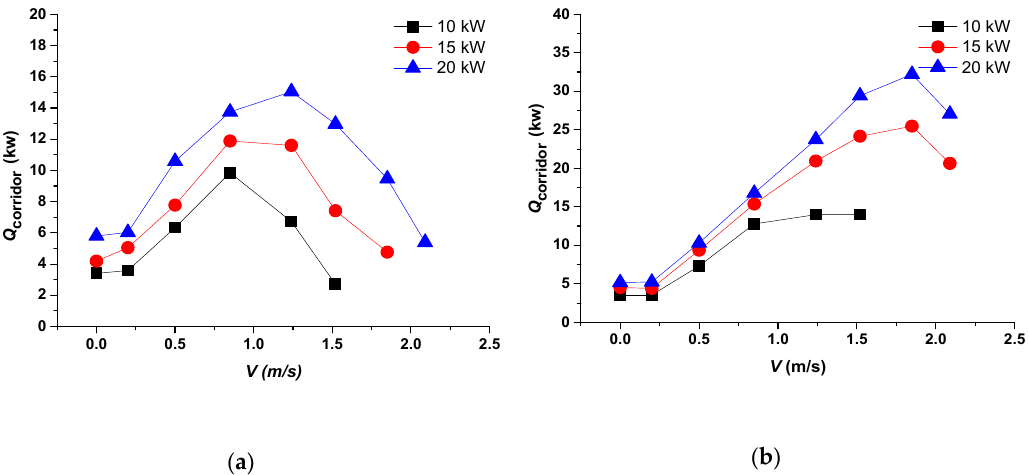
Figure 7. E ff ective HRR in the corridor ( Q corridor ): ( a ) fully open to the environment; ( b ) partially open to the